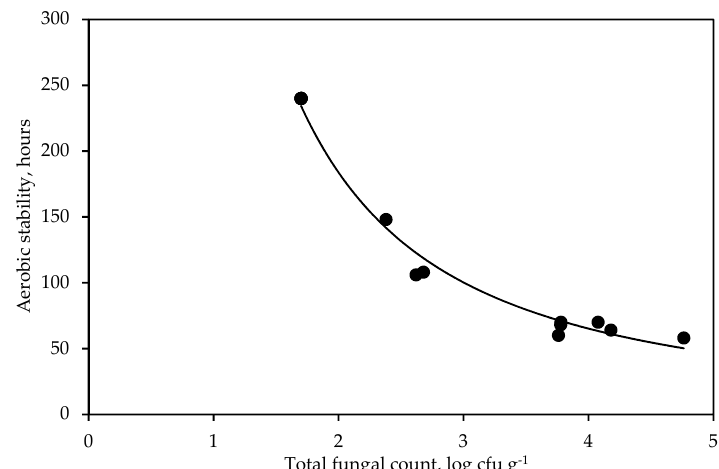
Figure 2. Relationship between the total fungal count at silo opening (x) and the aerobic stability (y) in early-cut rye silage treated with additives of different type and composition and stored for 64 days upon subsequent air exposure for 240 h. R 2 = 0.98, root mean square error (RMSE) = 0.09, p < 0.001, n = 15.